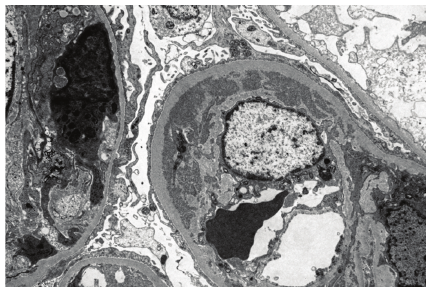
Figure 4: Membranoproliferative glomerulonephritis: endocapil- lary proliferation with extensive subendothelial deposits along the glomerular capillary walls. Mesangial deposits are present as well (electron microscopy).